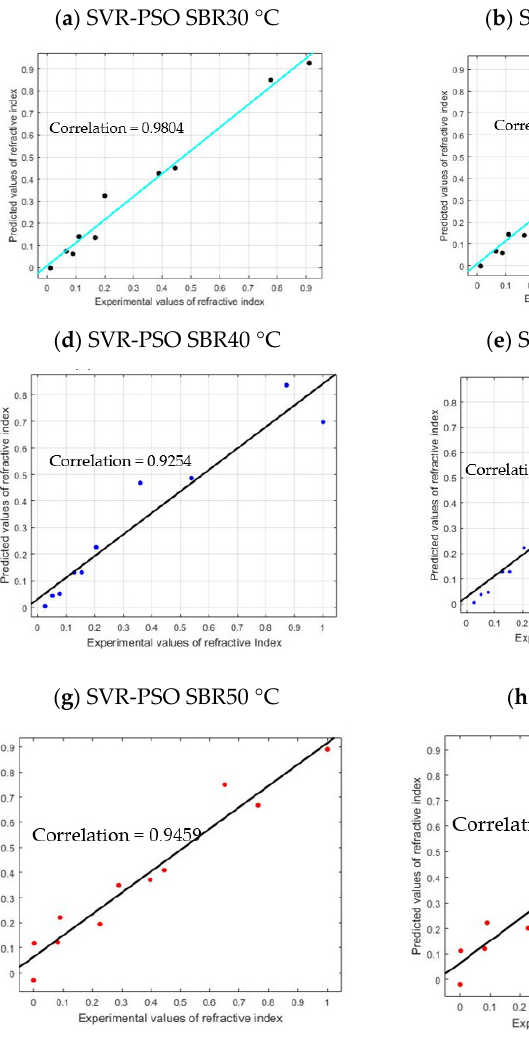
Figure 10. Cross plot validation of each model. Table 7. Goodness of fit for each model.